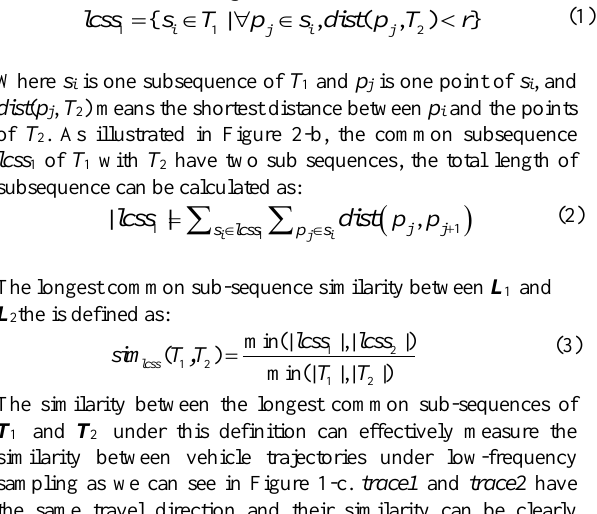
Figure 2. Illustration of trajectory resampling(a: Original trajectory data; b: Trajectory data after resampling) After the track resampling, define the common subsequence with r as the threshold (Figure